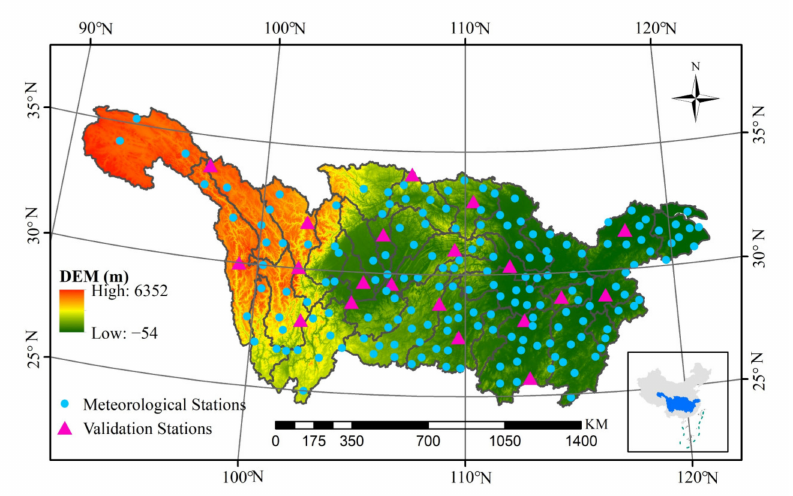
Figure 1. The geographical location of Yangtze River Basin. The blue points represent the meteo- rological stations used for model training while the purple triangles indicate the stations used for model